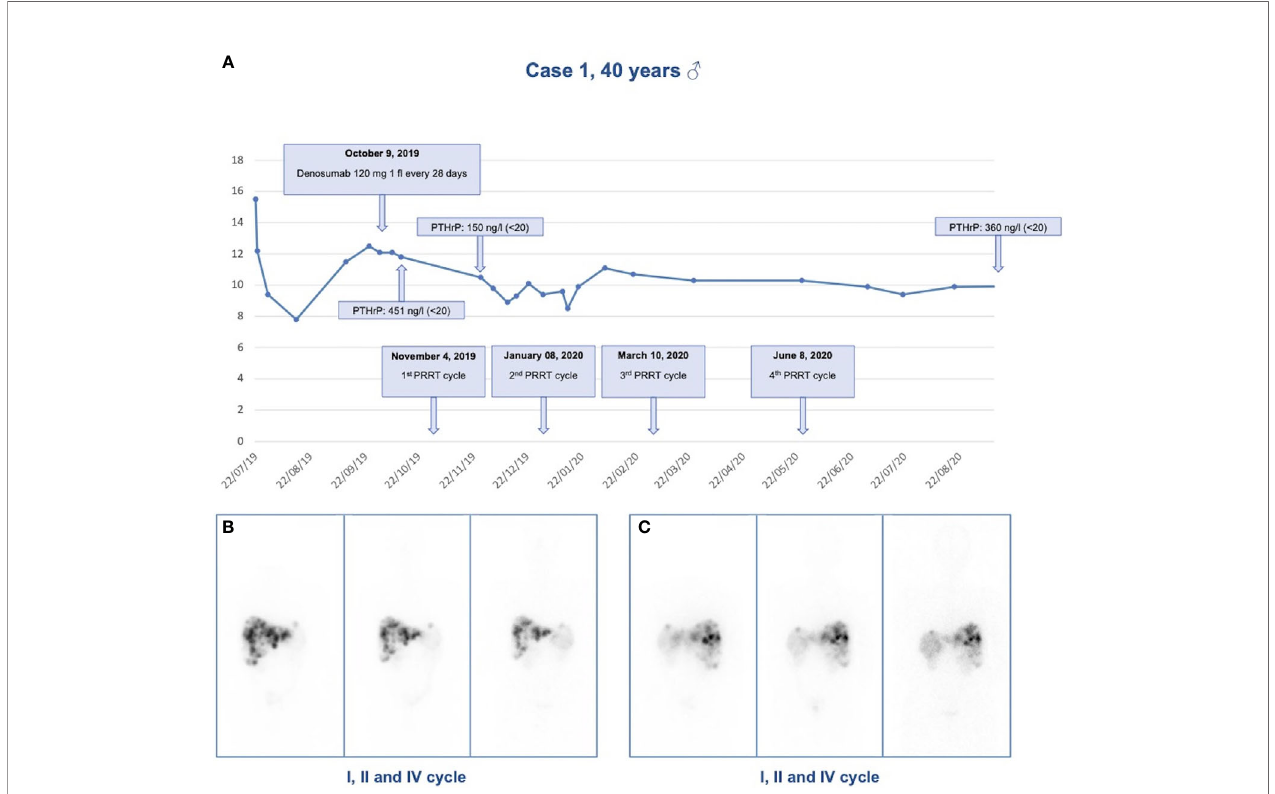
FIGURE 2 | Response to treatment in Case 1. (A) Calcium levels in relationship to denosumab administration and PRRT cycles in case 1; (B) Anterior view of 177 Lu- LUTATHERA scintigraphy after I, II, and IV cycles of PRRT; (C) Posterior view of 177 Lu-LUTATHERA scintigraphy after I, II, and IV cycles of